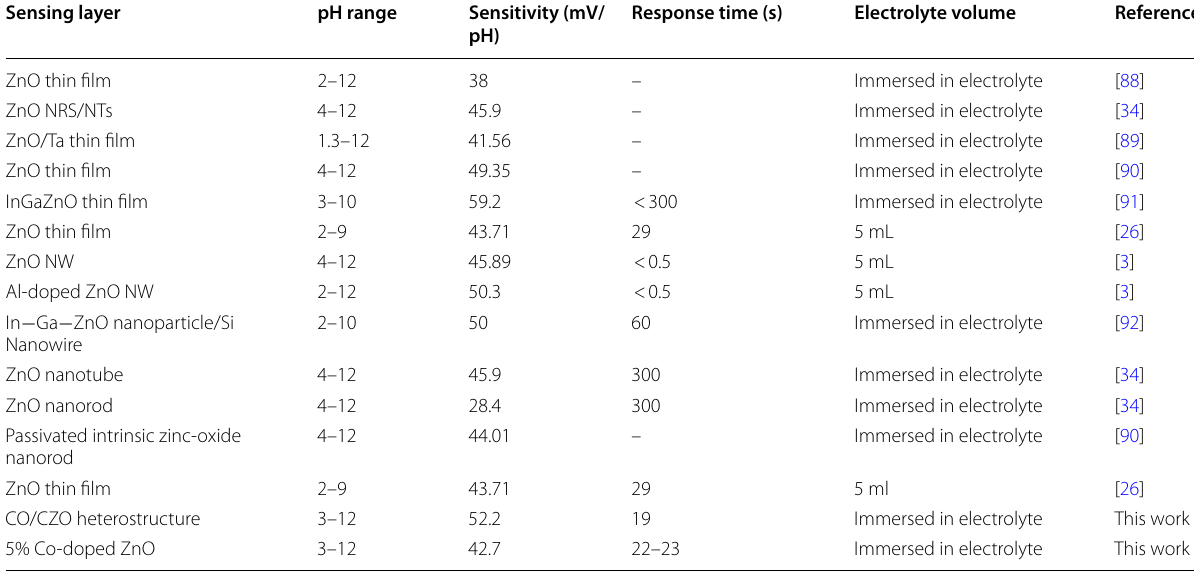
Table 1 Performance comparison of ZnO-based pH sensor with those reported previously Sensing layer